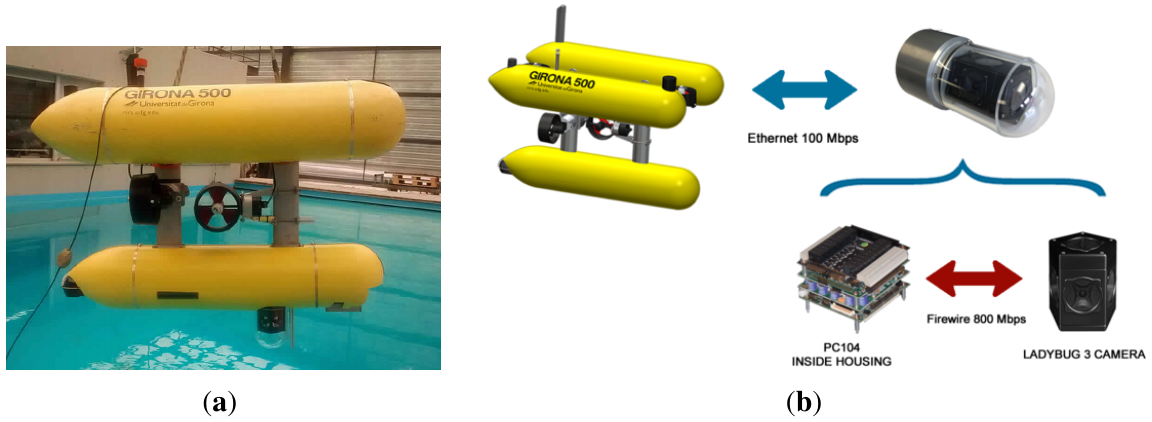
Figure 1. Integration of the omnidirectional camera in the Girona500 AUV. ( a ) The omnidirectional camera integrated with the Girona500 AUV in the CIRS (Underwater Robotics Research Centre) water tank; ( b ) scheme of the communications between the Girona500 AUV and the omnidirectional